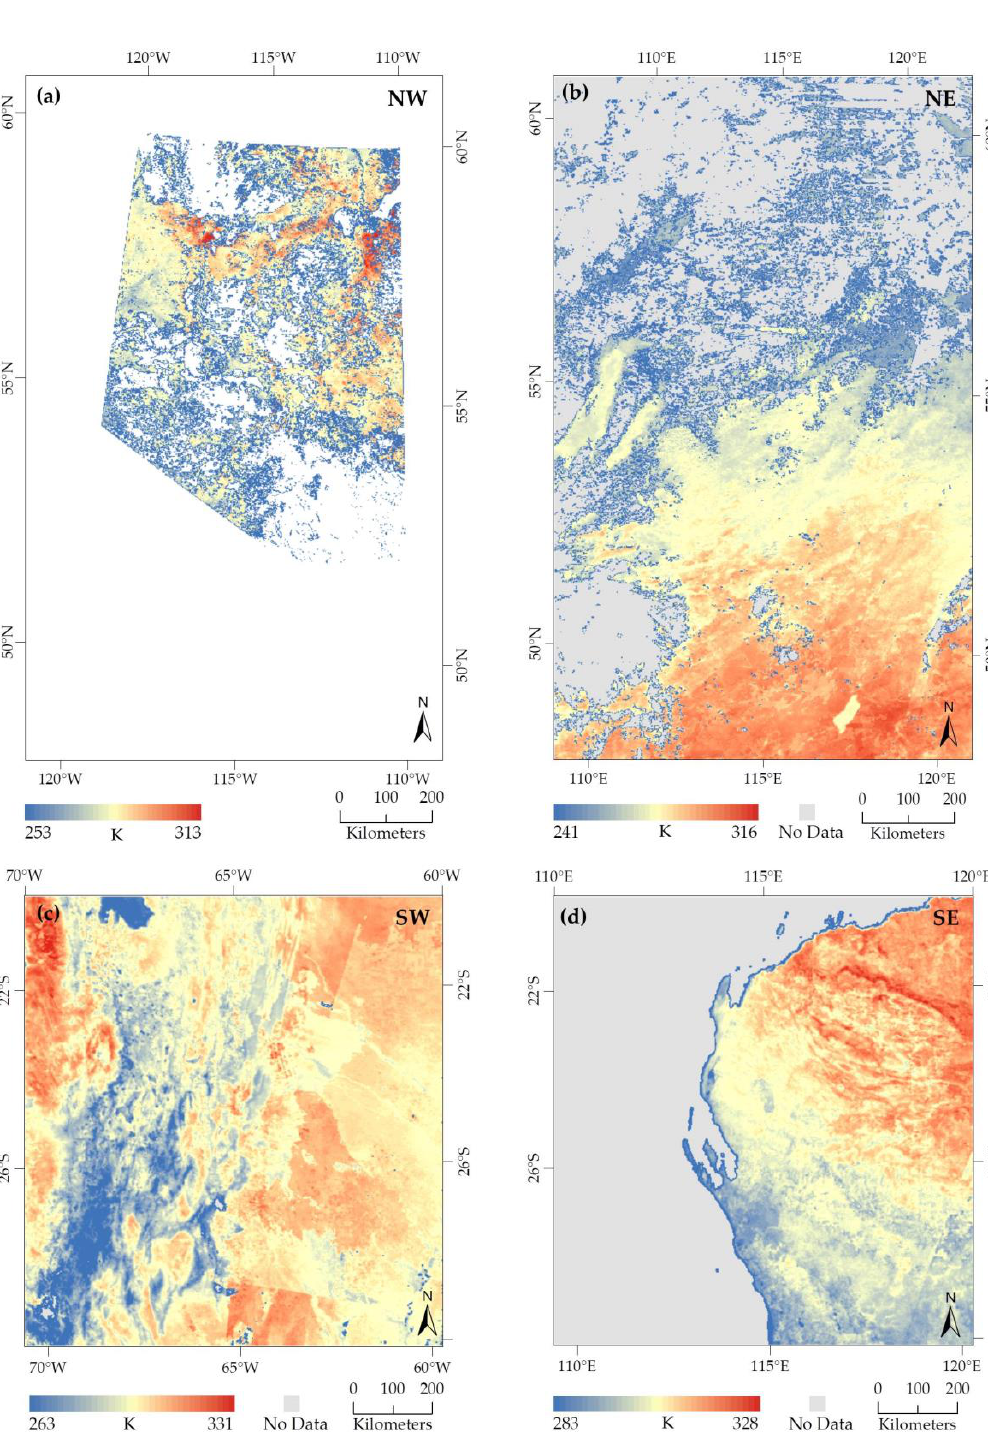
Figure 6. 4-day composites of Ts derived from four daily Ts images of each AOI. The dates of daily Ts images spanning over a four-day composition period were: ( a ) NW: DOY 236 to 239 (24 – 27 August 2019); ( b ) NE: DOY 272 to 275 (29 September – 2 October 2019); ( c ) SW: DOY 273 to 276 (30 September – 3 October 2019); and ( d ) SE: DOY 272 to 275 (29 September – 2 October 2019).